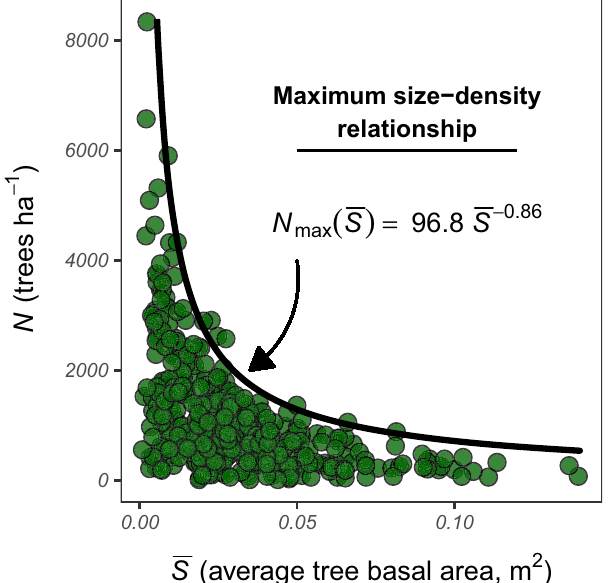
Fig. 6 Maximum size-density relationship for an example stand-type. Individual points represent observed stand-level indices of tree density ( N ) and average tree size ( S ). Maximum tree density ( N ) is modeled as a max power function of average tree size within a stand. Here, we use quantile regression to estimate N as the 99th percentile of N conditional on S . max The resulting maximum size-density curve can then be used to compute the relative density of observed stands (RD), where relative density is de fi ned as ratio of observed tree density ( N ) to maximum theoretical density ( N max ), given S . Source data are provided as a Source Data fi